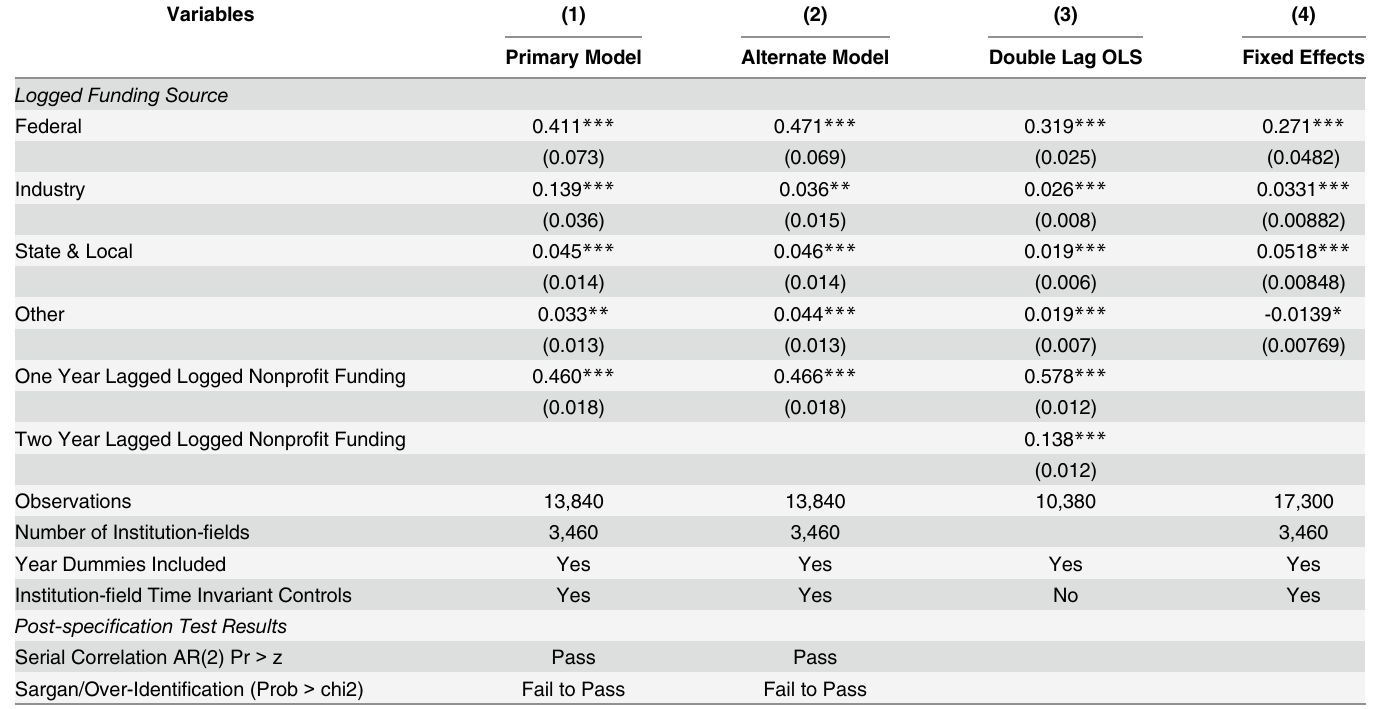
Table 5. Nonprofit R&D Log Expenditure Regression Results, Additional Model